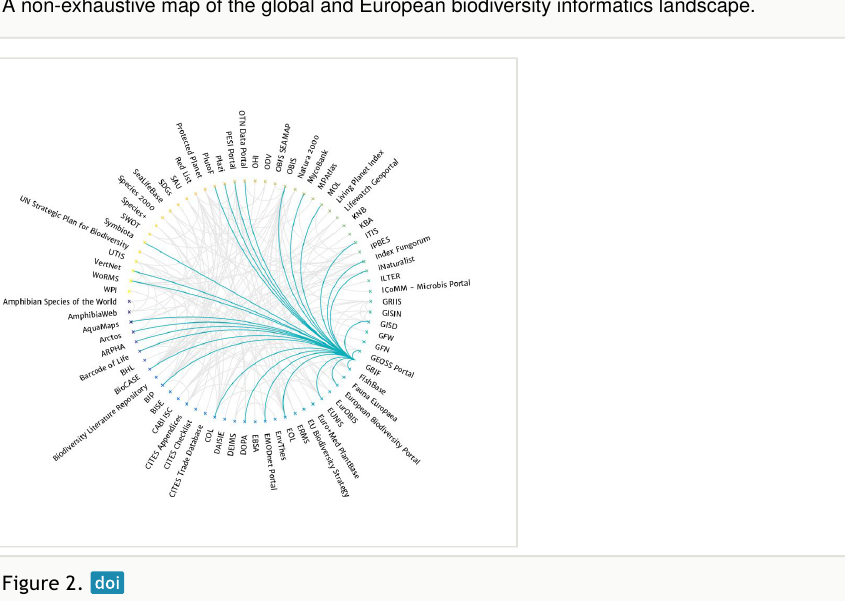
Figure 1. A non-exhaustive map of the global and European biodiversity informatics landscape.